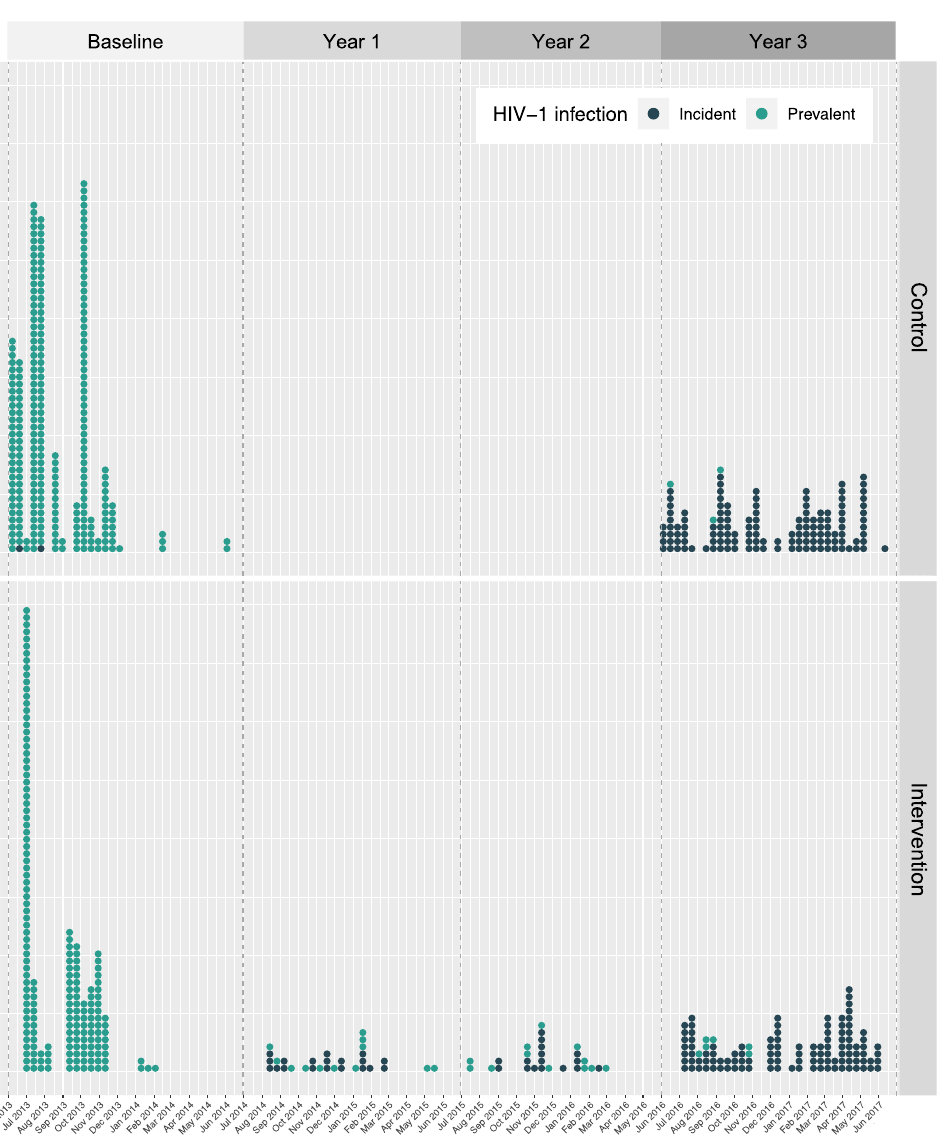
Figure 2. Sequencing intensity dot plot of the control (top) and intervention (bottom) arms of the SEARCH trial, with distinction between incident (dark) and prevalent (light) infections. Screening frequency differed between the intervention and control arms: yearly screening in intervention communities; baseline and year 3 screening only in control communities. Two incident infections were detected during rounds of baseline testing; most prevalent infections were detected at baseline, with the remaining picked up in later rounds.